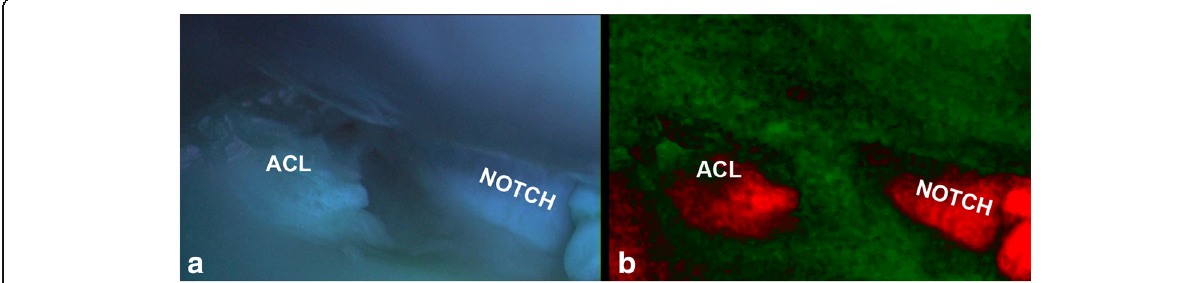
Fig. 5 Inferior view of femoral condyles in bovine knee. a color image of the fluorescent response as directly captured by the digital camera. Notice the subtle differences between the ACL site (bluish/greenish) and its surroundings. b Real-time unmixed result of the color image left, with red the ACL and part of PCL and in green the background composed of the cartilage and bone. Fibrocartilaged notch (typical for bovine knees) also reveals in